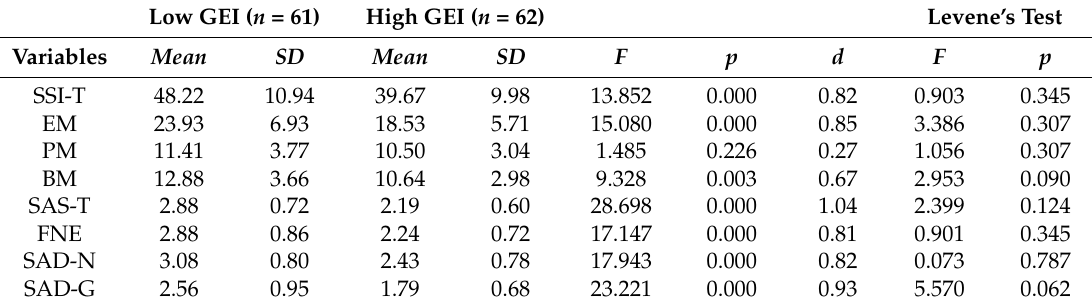
Table 4. Mean, standard deviation ( SD ), analysis of variance (ANOVA), and size of the effect of the differences in means (Cohen’s d ) as a function of GEI. Low GEI ( n = 61) High GEI ( n = 62) Levene’s Test